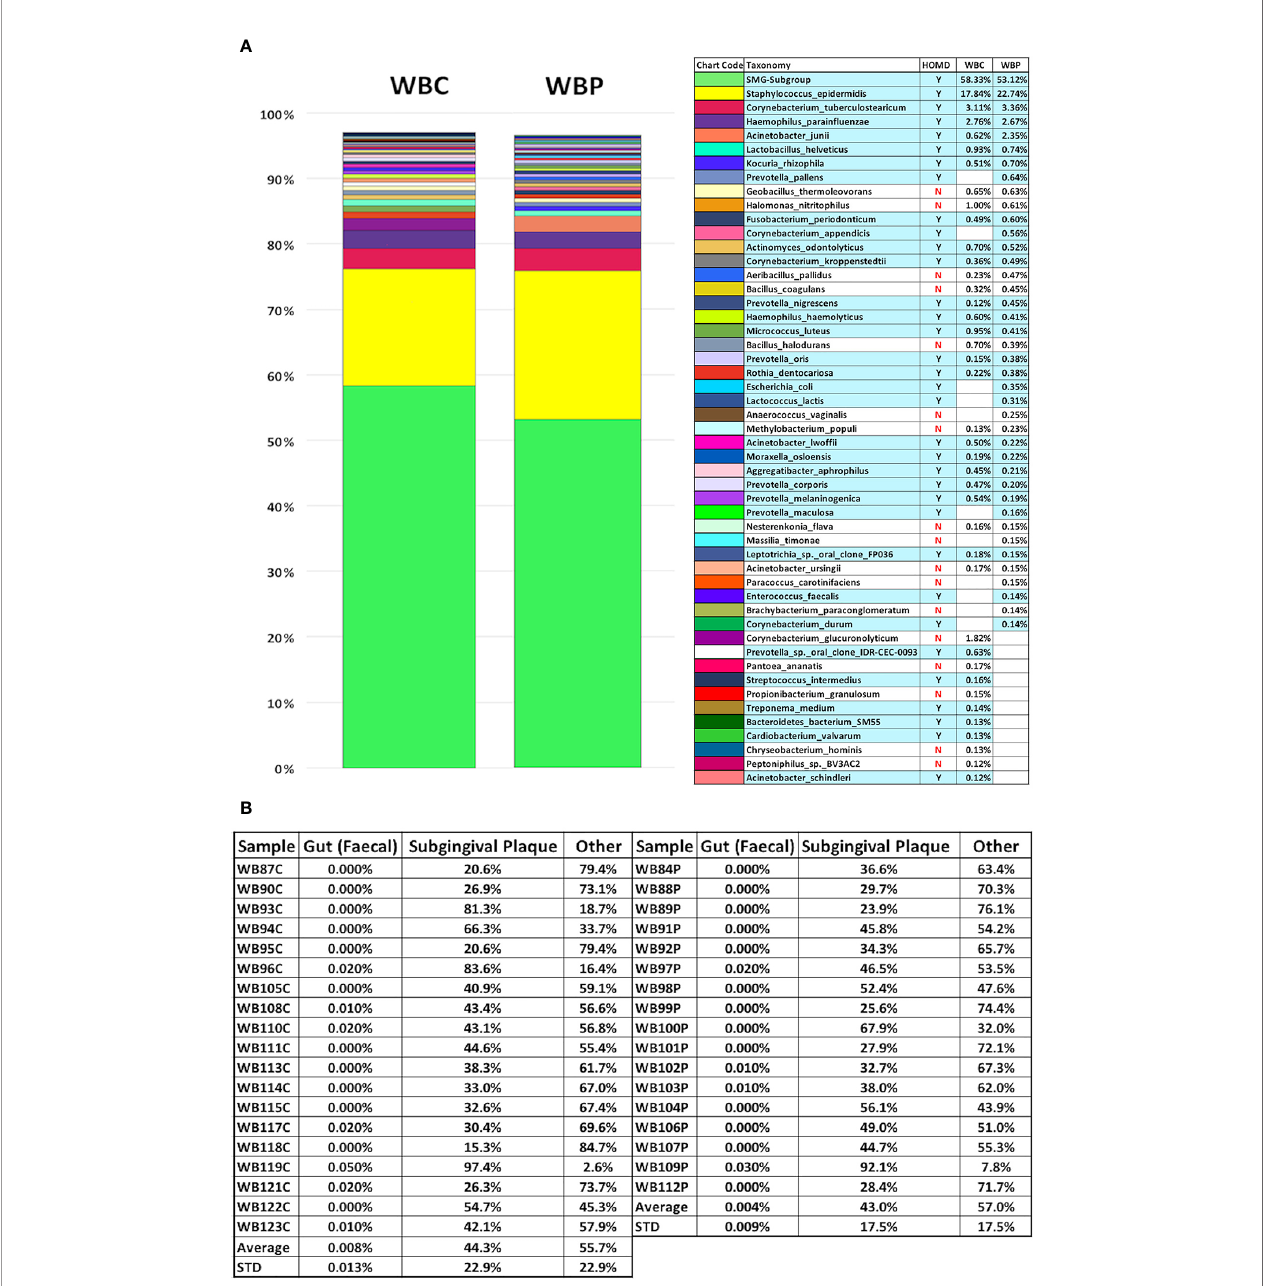
FIGURE 2 | Percentage composition of the 40 most abundant bacterial species in whole blood from the periodontally healthy (WBC) and severe periodontitis (WBP) groups displayed with potentially orally-derived taxa [found in the Human Oral Microbiome Database(homd.org)] indicated by y/n and highlighted in blue (A) and Source Tracker2 analysis using faecal and subgingival training datasets (B)